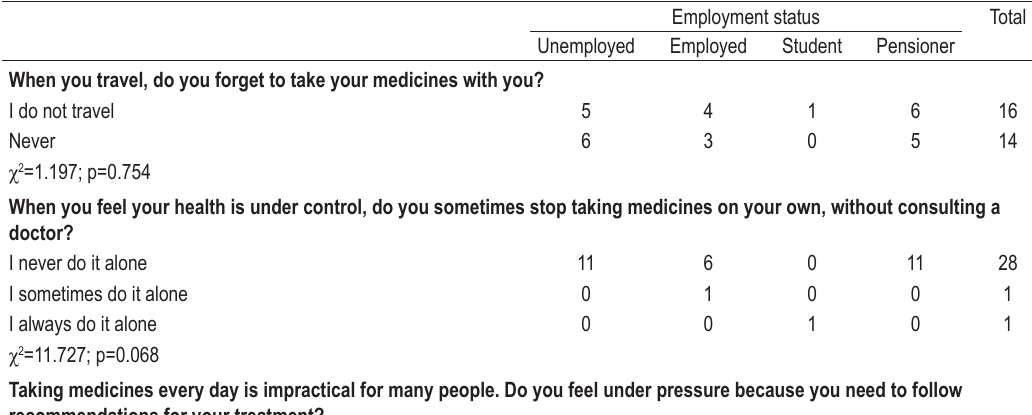
Table 5. Answers to questions on compliance